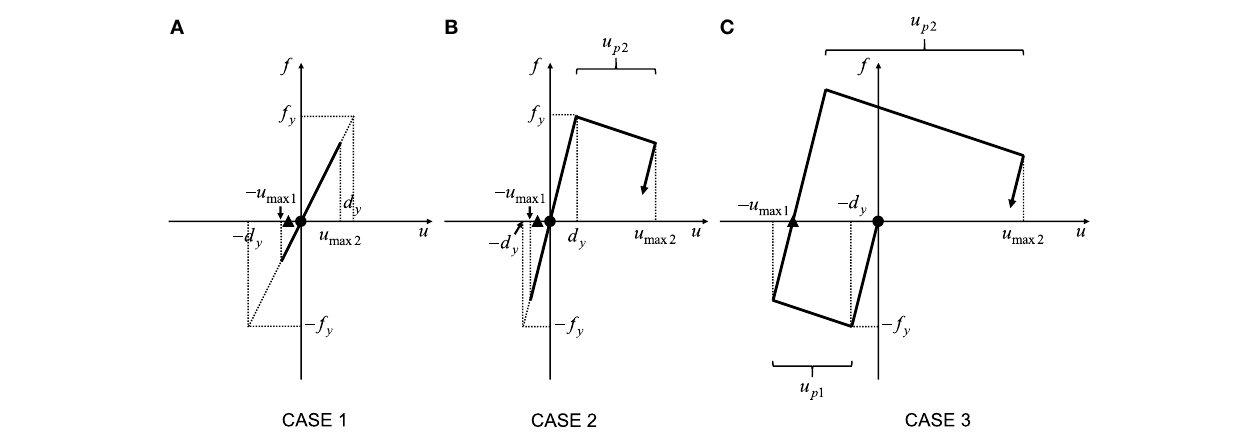
FIGURE A1 | Maximum elastic–plastic deformation of SDOF model with negative post-yield stiffness under double impulse: (A) Case 1: elastic response, (B) Case 2: plastic response after the second impulse, and (C) Case 3: plastic response after the first impulse ( (cid:15) : first impulse, N : second impulse)